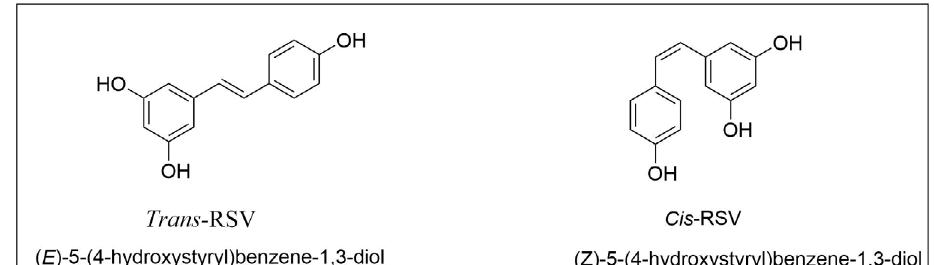
Figure 1. Chemical structure of RSV in the trans and cis form RSV: an